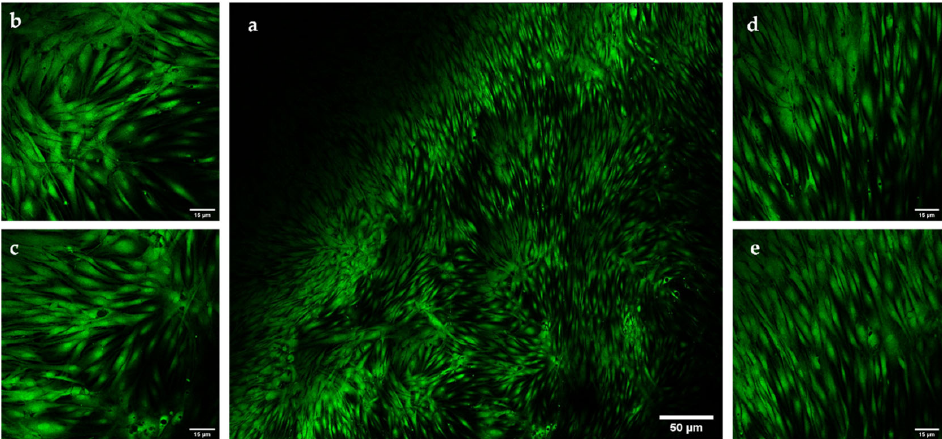
Figure 9. NHDF cells stained with LIVE/DEAD™ Kit observed under fluorescence confocal microscope after 144 h of incubation on sample HA25. The images on the sides ( b – e ) at magnification 63× are sections of the main picture ( a ), magnification 20×.